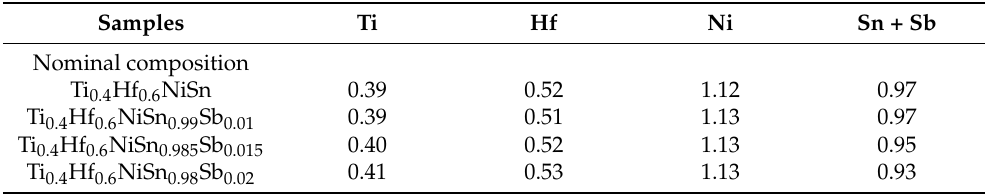
Table 1. EDS analysis of the Sb doped Ti 0.4 Hf 0.6 NiSn samples.